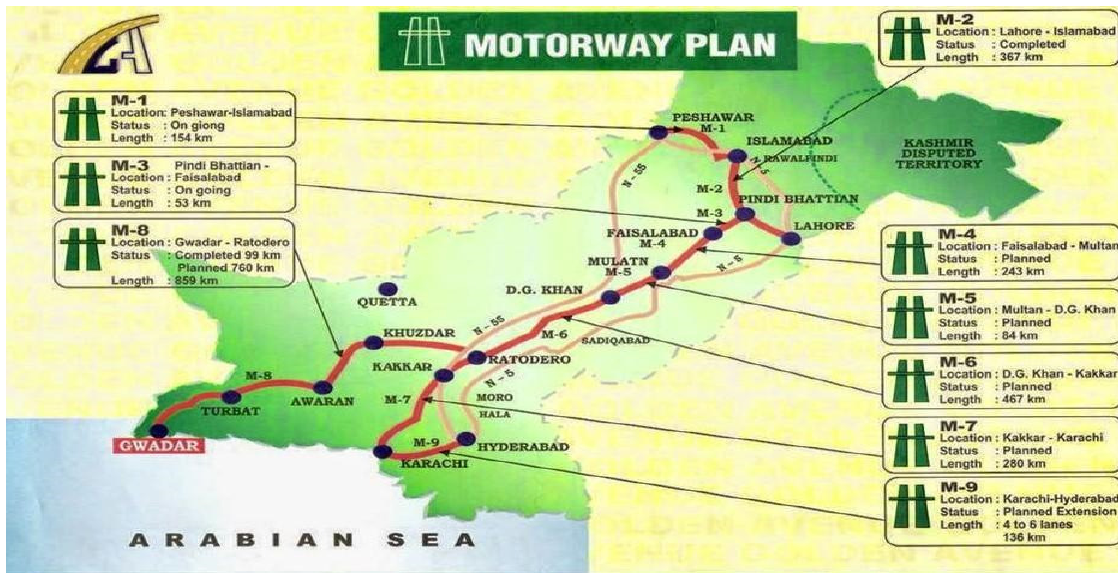
Fig. 1: Motorways system in Pakistan [Source: National Highway Authority,